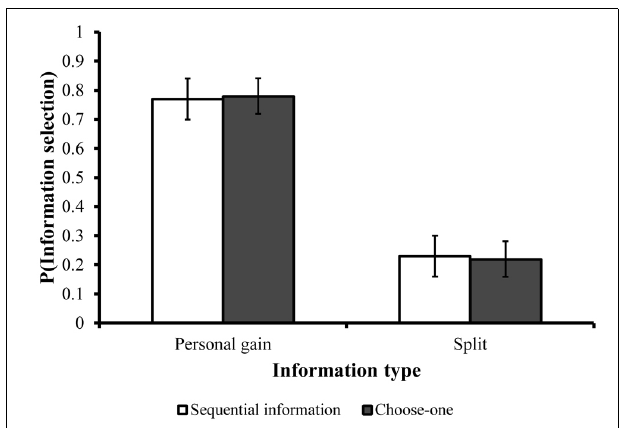
FIGURE 4 | Overall information search pattern and search pattern in the first phase in Experiment 3. Error bars are depicted in black lines.